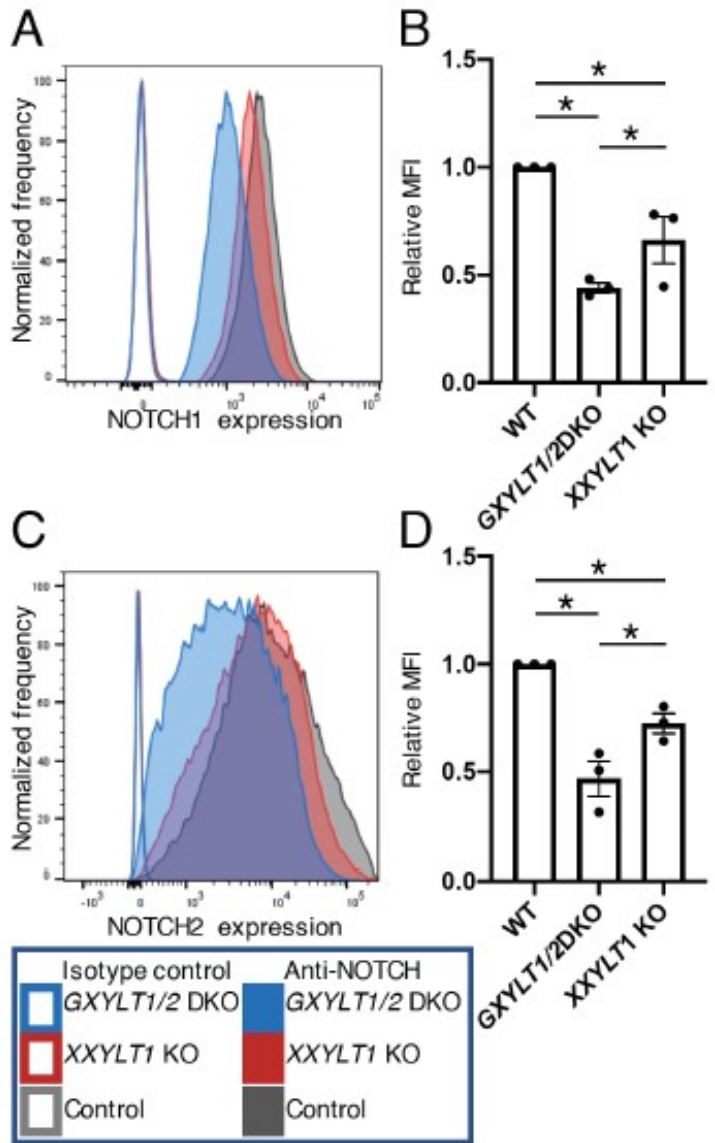
Figure 5. Xylosyl extension of O -Glc glycans enhances the cell surface expression of NOTCH1 or NOTCH2 overexpressed in HEK293T cells. ( A ) The cell surface expression of transfected full length NOTCH1 in the wild type and XYLTs’ KO clones of HEK293T cells analyzed by flow cytometry. Co-transfected GFP-positive cells were gated. ( B ) Mean fluorescence intensity from ( A ). Plots are from four independent experiments ( n = 4). Bar graphs show the average ± SEM. ( C ) Cell surface expression of transfected full length NOTCH2 in the wild type and XYLTs ’ KO clones of HEK293T cells analyzed by flow cytometry. Co-transfected GFP-positive cells were gated. ( D ) Mean fluorescence intensity from ( C ). Plots are from three independent experiments ( n = 3). Bar graphs show the average ± SEM. The cell numbers on the vertical axis of the graphs in ( A ) and ( C ) are normalized with the mode value. *, p < 0.05.